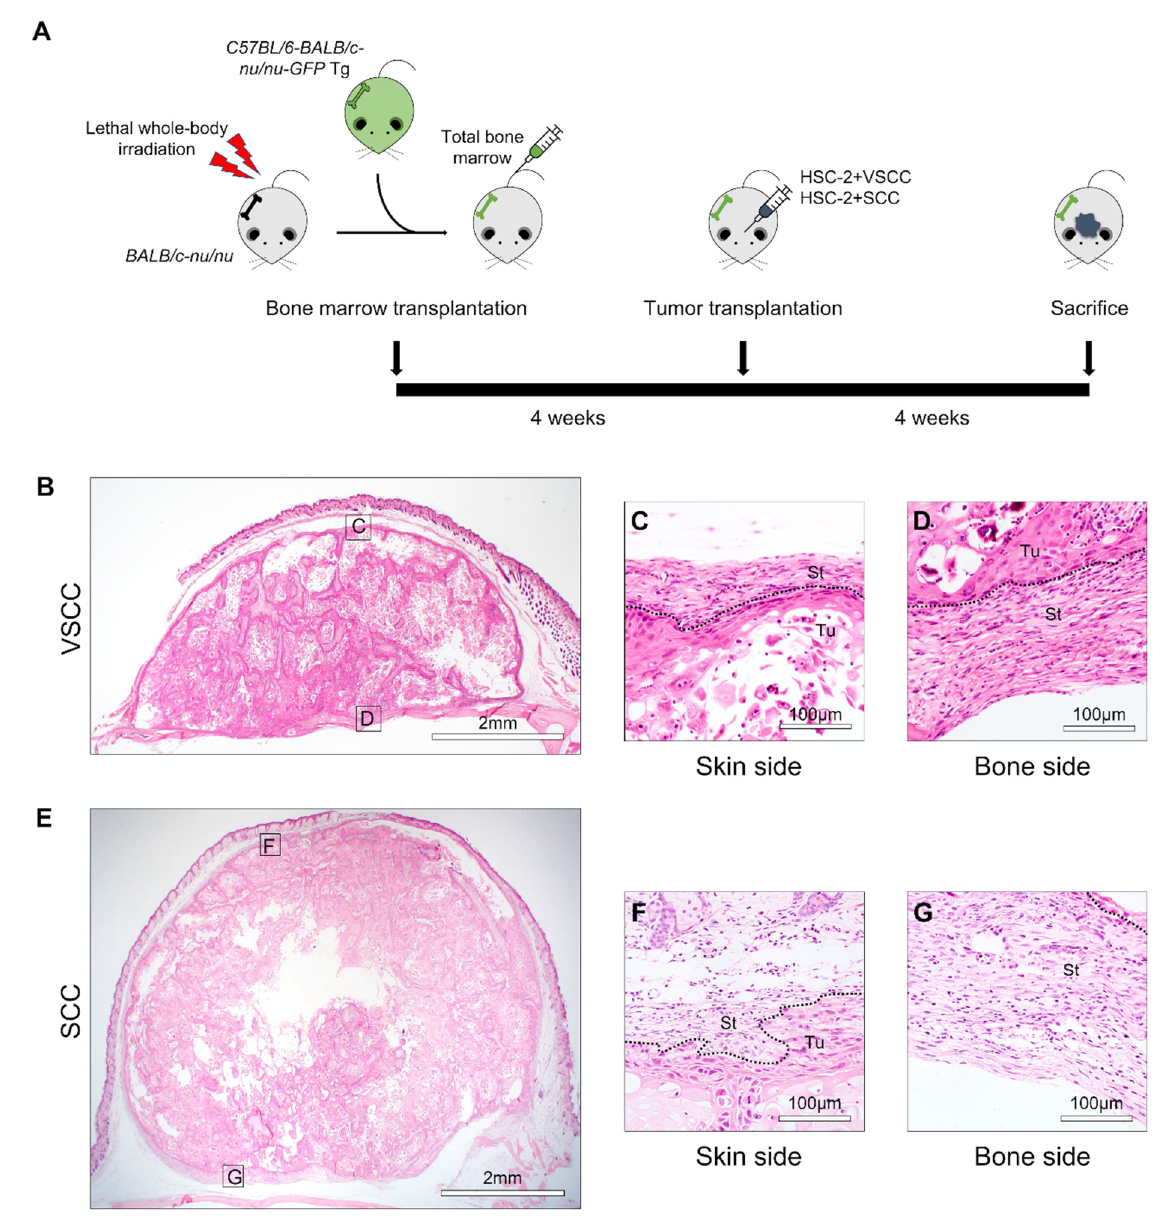
Figure 1. Histological characterization of VSCC-PDSX and SCC-PDSX: ( A ) Illustration of the establishment of OSCC-PDSX models. Bone marrow transplantation (BMT) with GFP-positive bone marrow cells is performed on lethal whole-body radiated nude mice. After 4 weeks, tumor transplantation is performed which allows tumors to grow for 4 weeks. Then, mice are sacrificed, and tumor tissues are harvested. ( B ) Representative images of hematoxylin and eosin (H&E) staining of VSCC-PDSX; ( C , D ) High magnified images of VSCC-PDSX ( C ) Skin side, ( D ) Bone; ( E ) Representative images of hematoxylin and eosin (H&E) staining of SCC-PDSX; ( F , G ) High magnified images of VSCC-PDSX ( F ) Skin side, ( G ) Bone side. Dotted lines represent the boundary of the tumor (Tu) and the stroma (St). VSCC, verrucous oral squamous cells carcinoma; SCC, conventional oral squamous cell carcinoma, PDSX, patient-derived stromal cells xenograft; OSCC, oral squamous cell carcinoma.